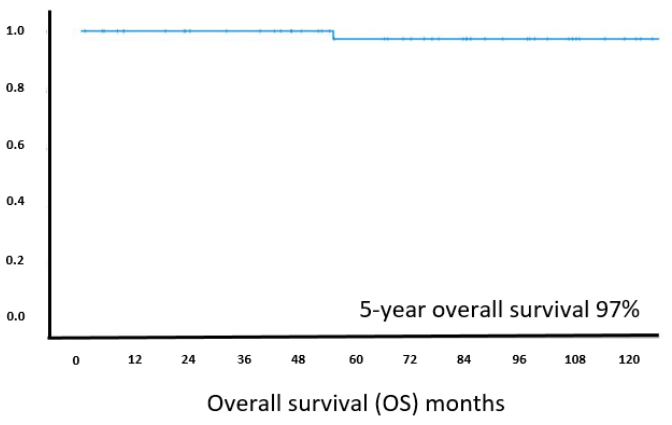
Figure 5. Kaplan–Meier curve for estimated overall survival in H. pylori negative MALT lymphoma patients ( n = 57). X-axis: follow-up in months, Y-axis: cumulative overall